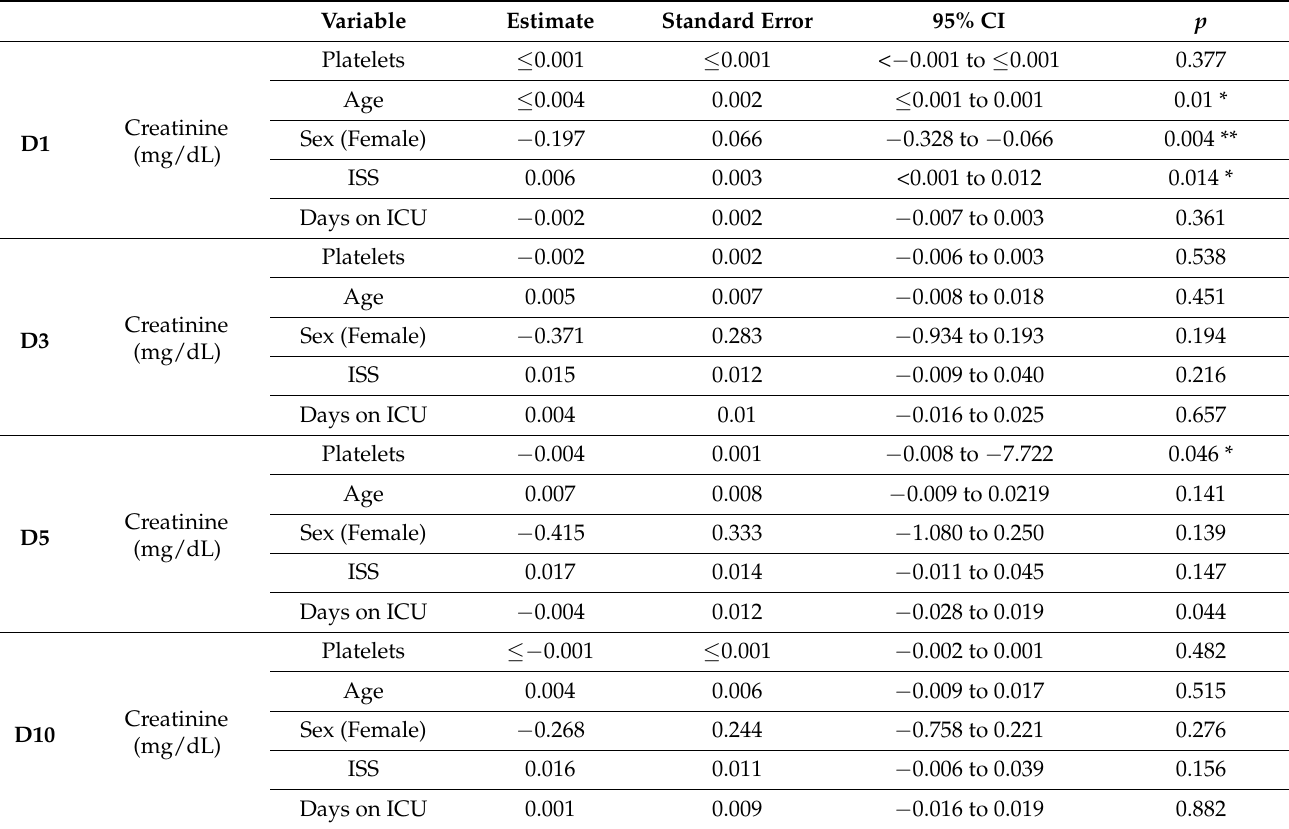
Table 2. Multiple linear regression with creatinine concentration as a dependent variable and platelet count, age, sex, injury severity, and length of ICU stay as independent variables on day (D) 1, 3, 5, and 10. Variable Estimate Standard Error 95% CI